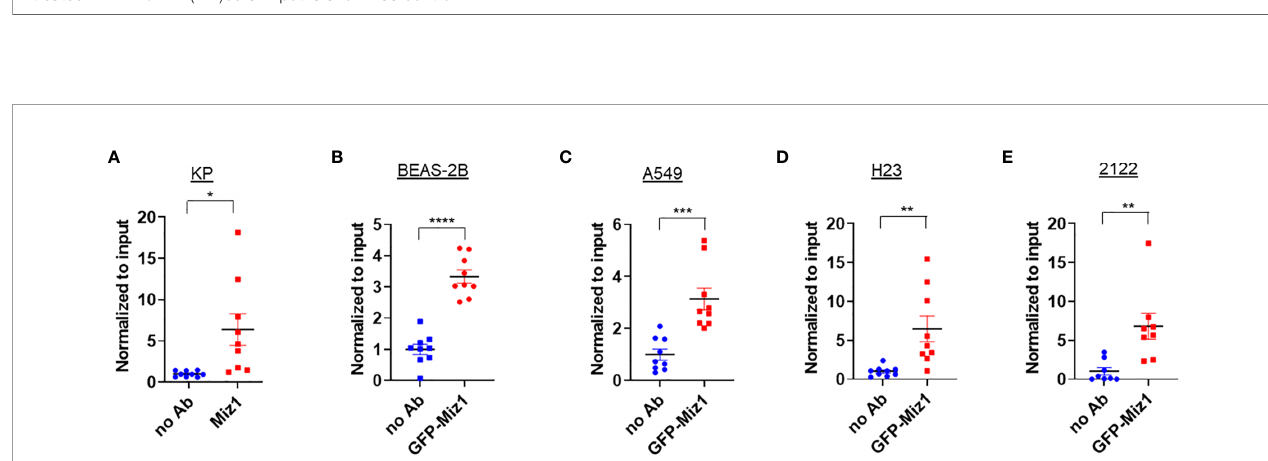
FIGURE 2 | Miz1 binds to the Ace2 promoter in a POZ-domain dependent manner and TNF reduces Miz1 binding in mouse lung epithelial cells as analyzed by ChIP-seq. (A) ChIP-seq traces of wild type or mutant Miz1 proteins ( d POZ or S178A) on the Ace2 promoter. Input is shown as control. (B) ChIP-seq traces of RNA Pol II on the Ace2 promoter in MLE-12/Miz1(WT) and MLE-12/Miz1( d POZ) cells. Input is shown as control. (C) ChIP-seq traces of Miz1 on the Ace2 promoter in TNF-non-treated or -treated MLE-12/Miz1(WT) cells. Input is shown as control. (D) ChIP-seq traces of RNA Pol II on the Ace2 promoter in TNF-non-treated or -treated MLE-12/Miz1(WT)cells. Input is shown as